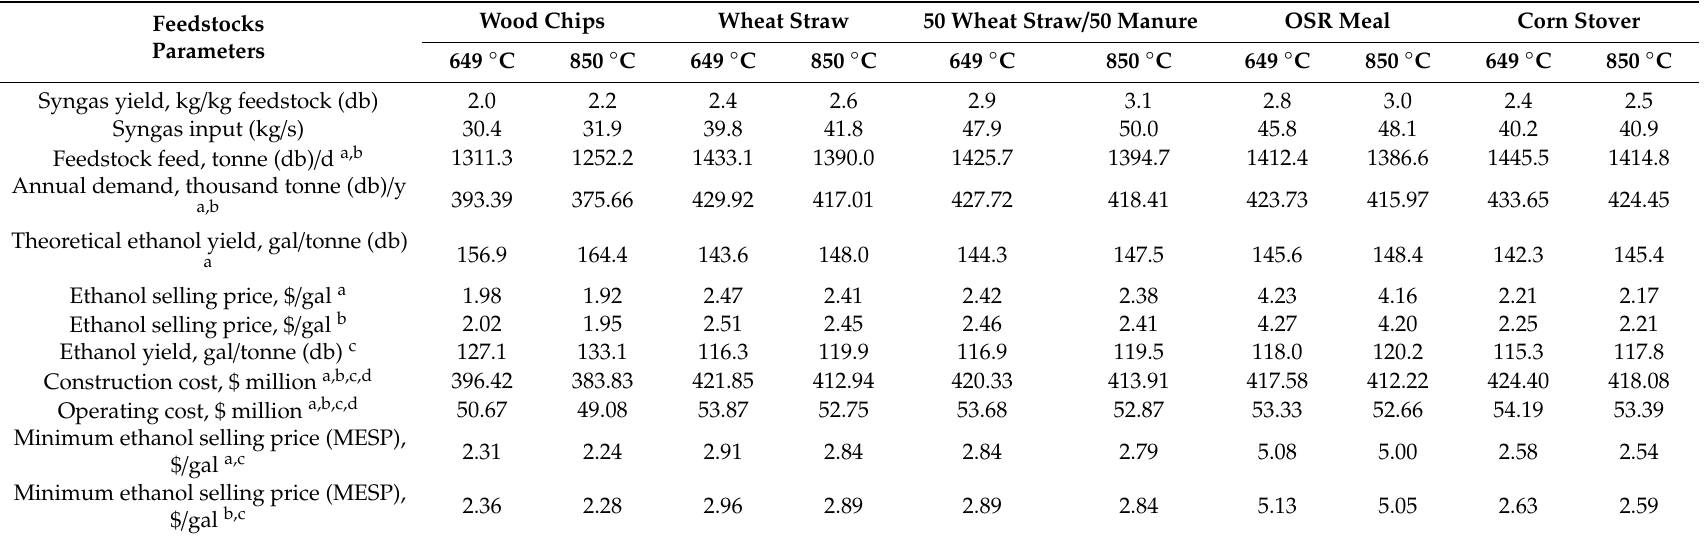
Table 5. Case 1—Comparison of feedstock feed rate, syngas and ethanol yield and ethanol selling prices from gasification and syngas fermentation of 30–50 kg /